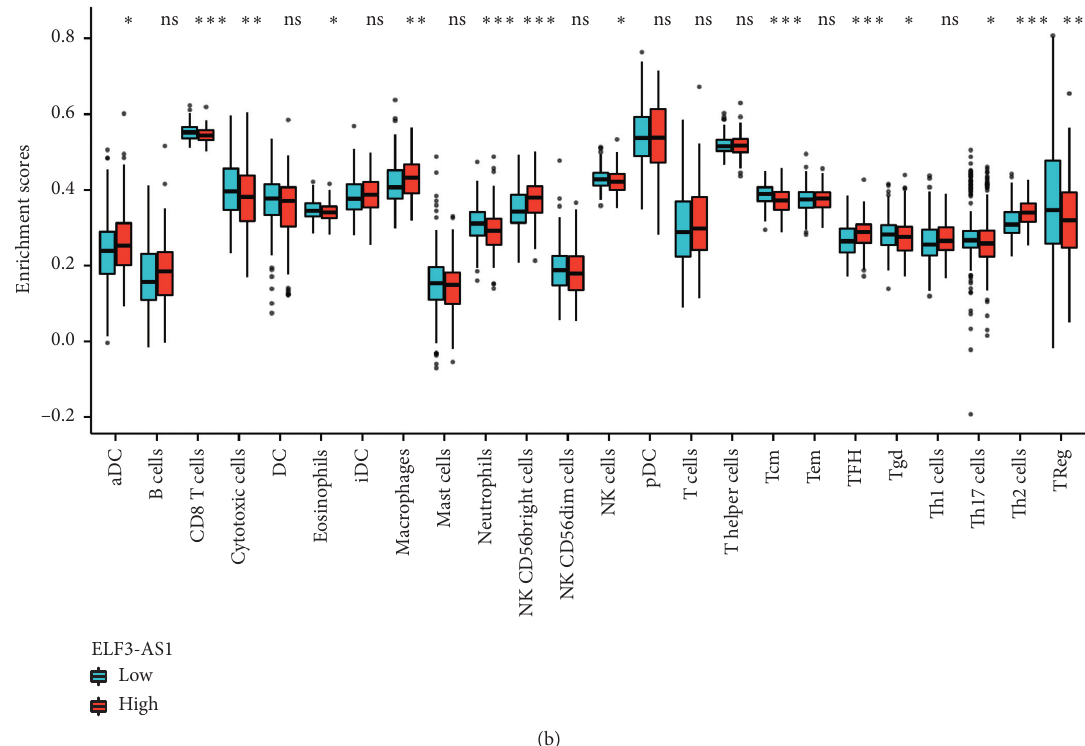
Figure 5: ELF3-AS1 expression is associated with immune infiltration in the tumor microenvironment of HCC. (a) Correlation between ELF3-AS1 expression and 24 immune cells (Spear). (b) Differences in immune cell enrichment scores between ELF3-AS1 high and low expression groups (Wilcoxon rank sum test).